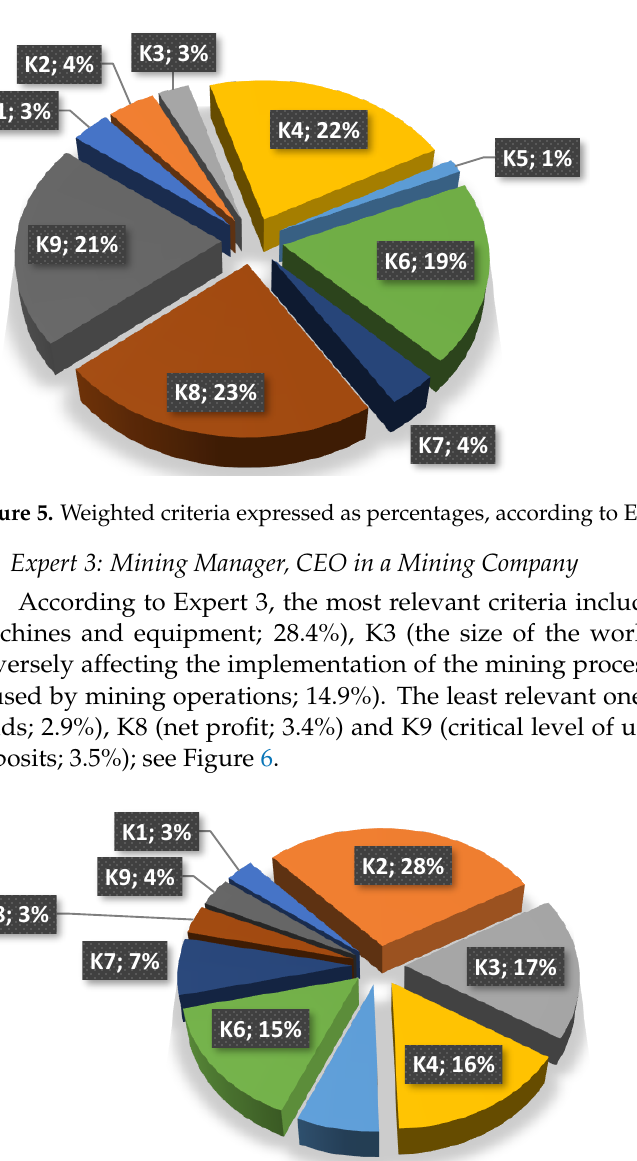
Figure 6. Weighted criteria expressed as percentages, according to Expert 3.